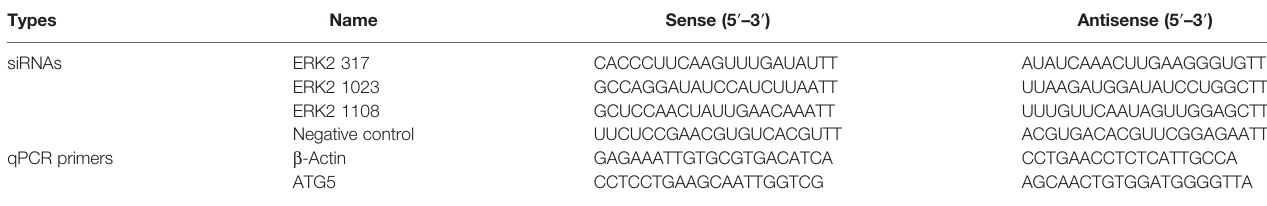
TABLE 1 | Sequences of siRNA for ERK2 and primers used for qPCR